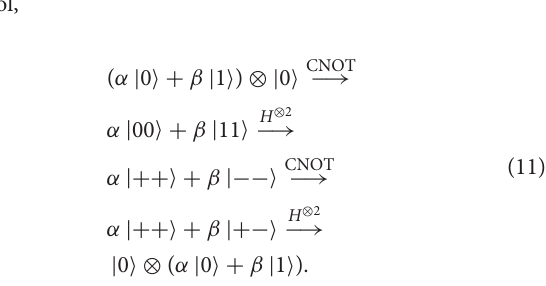
pass block . Alice’s incoming photon is first separated into H and V components using polarizing beamsplitter µ | i + | i